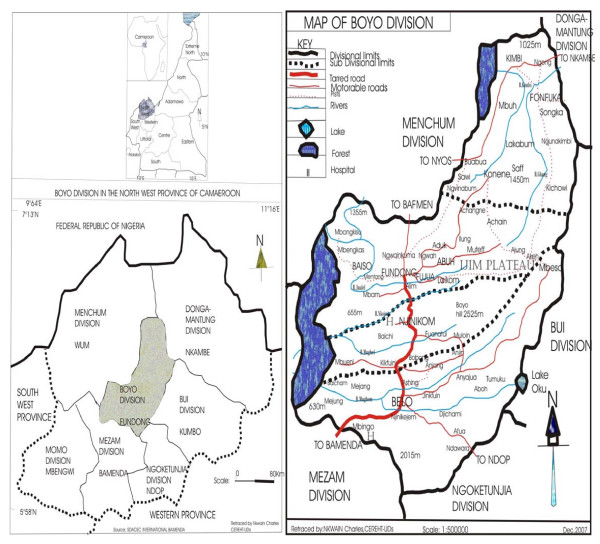
Map of Boyo region.